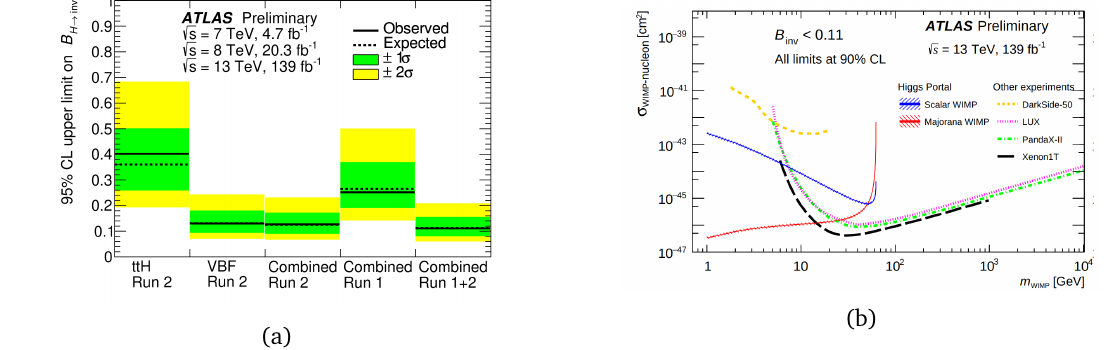
Figure 4: (a) Preliminary combination of Run 1 and Run 2 ATLAS results for invisi- ble Higgs boson decays [ 14 ] . (b) Comparison of upper limits on the WIMP-nucleon